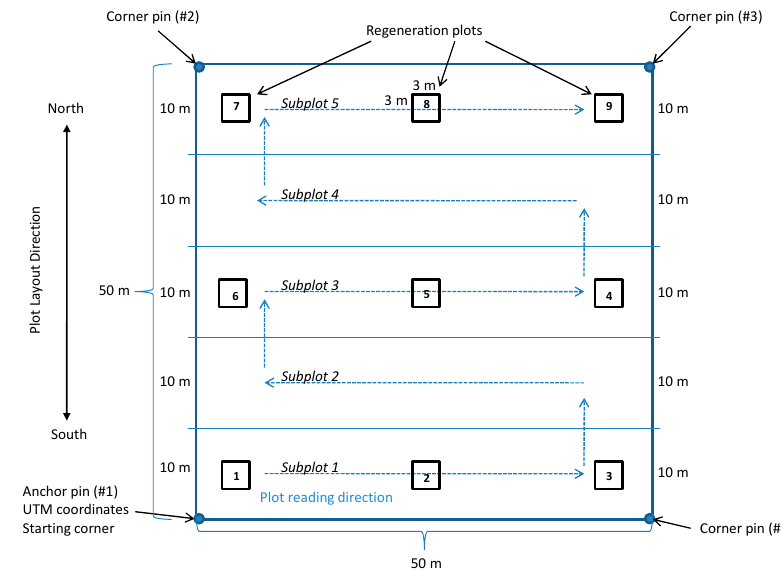
Figure 7. 50 × 50 m permanent plot layout. Smaller 3 × 3 m regeneration plots (numbered one through nine) are where seedlings are measured (Figure from McKinney et al.